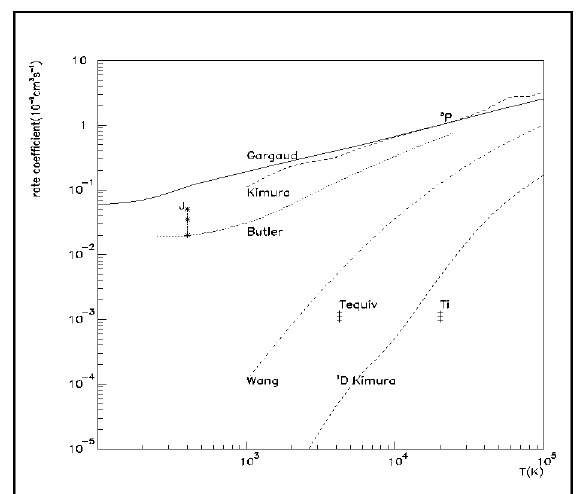
Fig. 4 : Rate coefficients as a function of temperature for O 2+ + He. Comparison of close-coupling calculations, Gargaud et al. [3] (full curve) ; Kimura et al. [18] (broken curves) ; Butler et al. [19] (dotted curve) and multichannel Landau-Zener approach, Wang et al. [20] (dotted-broken